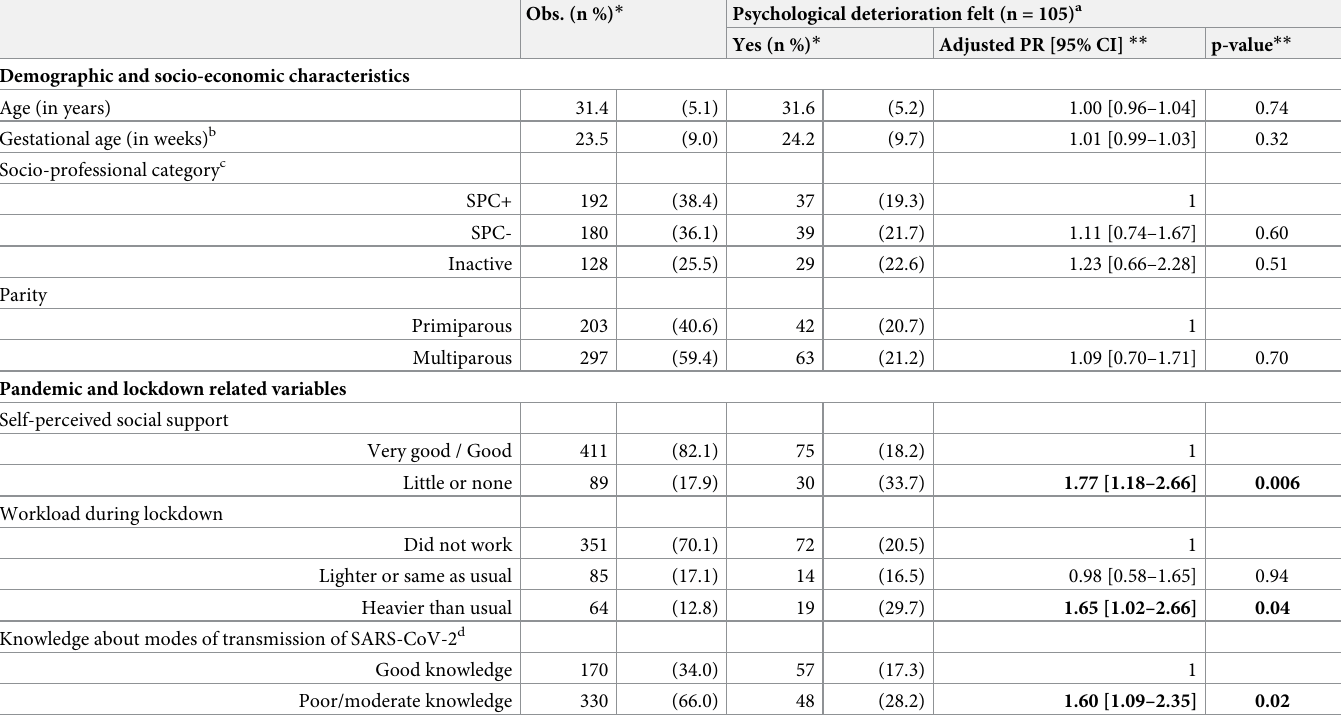
Table 2. Factors associated with psychological deterioration felt during lockdown, Covimater survey (n = 500), France (July 2020).